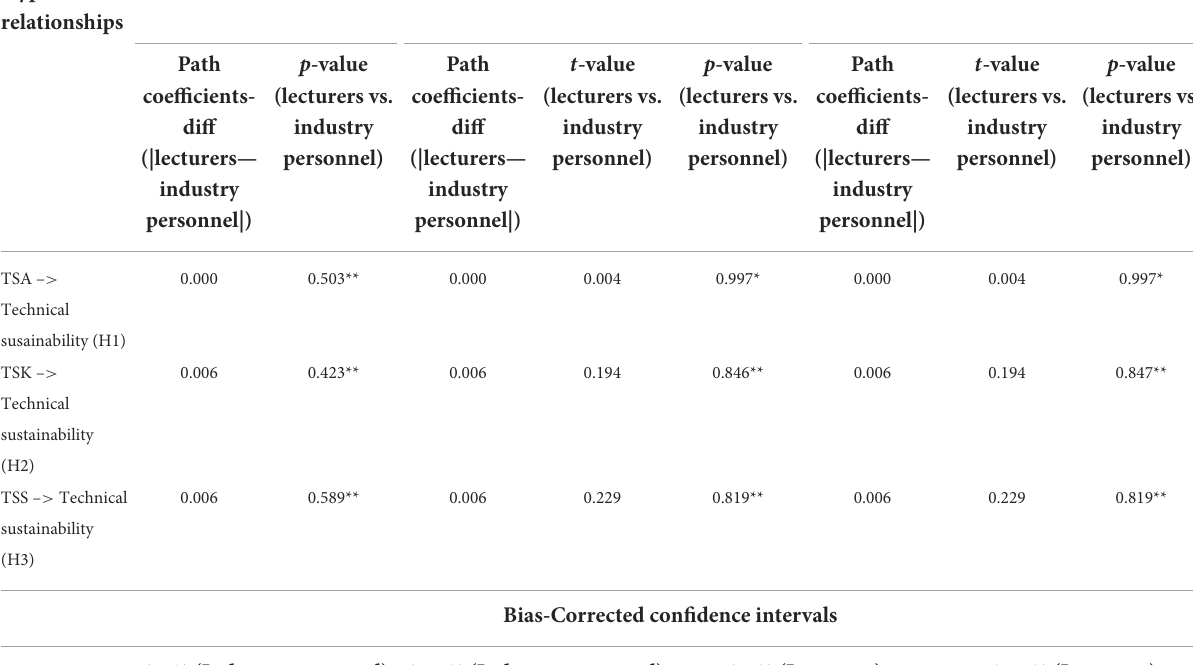
TABLE 8 Results of multi-group